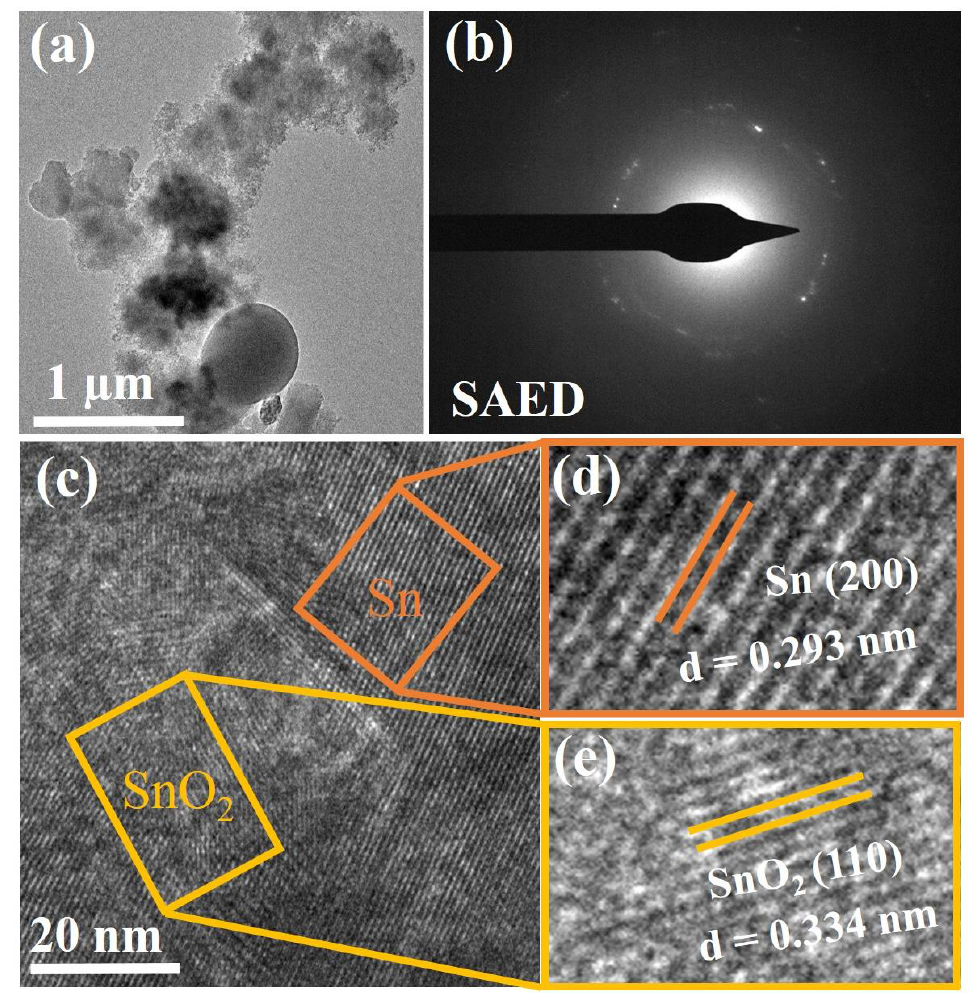
Figure 3. ( a ) TEM image of the Sn/C composite; ( b ) SAED pattern of the composite; and ( c – e ) HRTEM and enlarged image of the Sn/SnO 2 /C nano-composite.